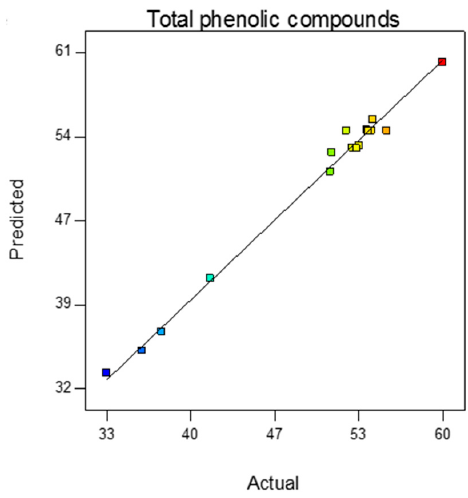
Figure 1. Predicted versus experimental values for total phenolic compounds (TPC) content in the EOP extracts.